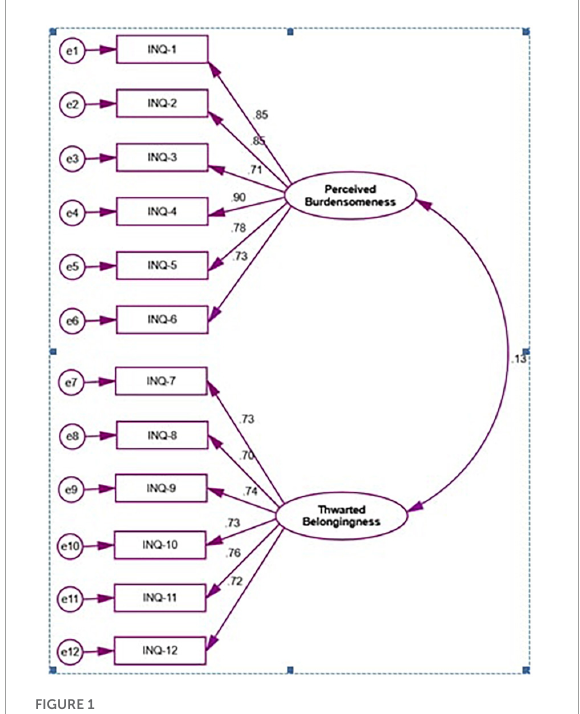
FIGURE1 First order confirmatory factor analysis of INQ-B.